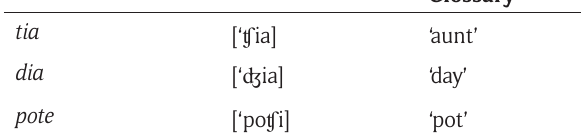
Table 5: Palatalization of /t/, /d/ preceding the oral vowel /i/.